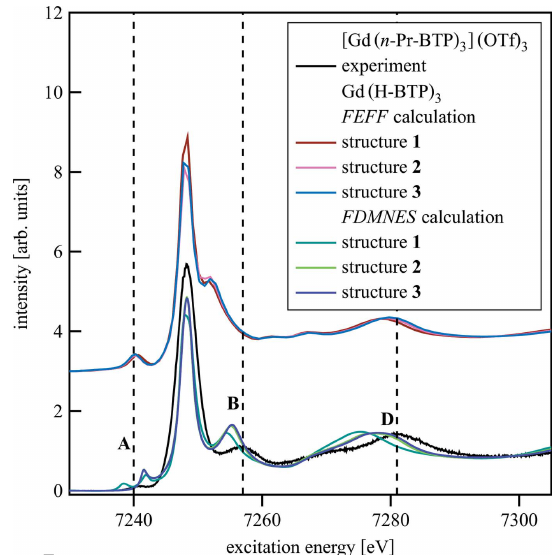
Figure 7 [Gd( n -Pr-BTP) 3 ](OTf) 3 experimental spectrum compared with Gd(H- BTP) 3 spectra calculated with FEFF and FDMNES for DFT optimized structures with symmetry restrictions (structure 1 ), without symmetry restrictions (structure 2 ) and without symmetry restrictions and a solvation sphere (structure 3 ).